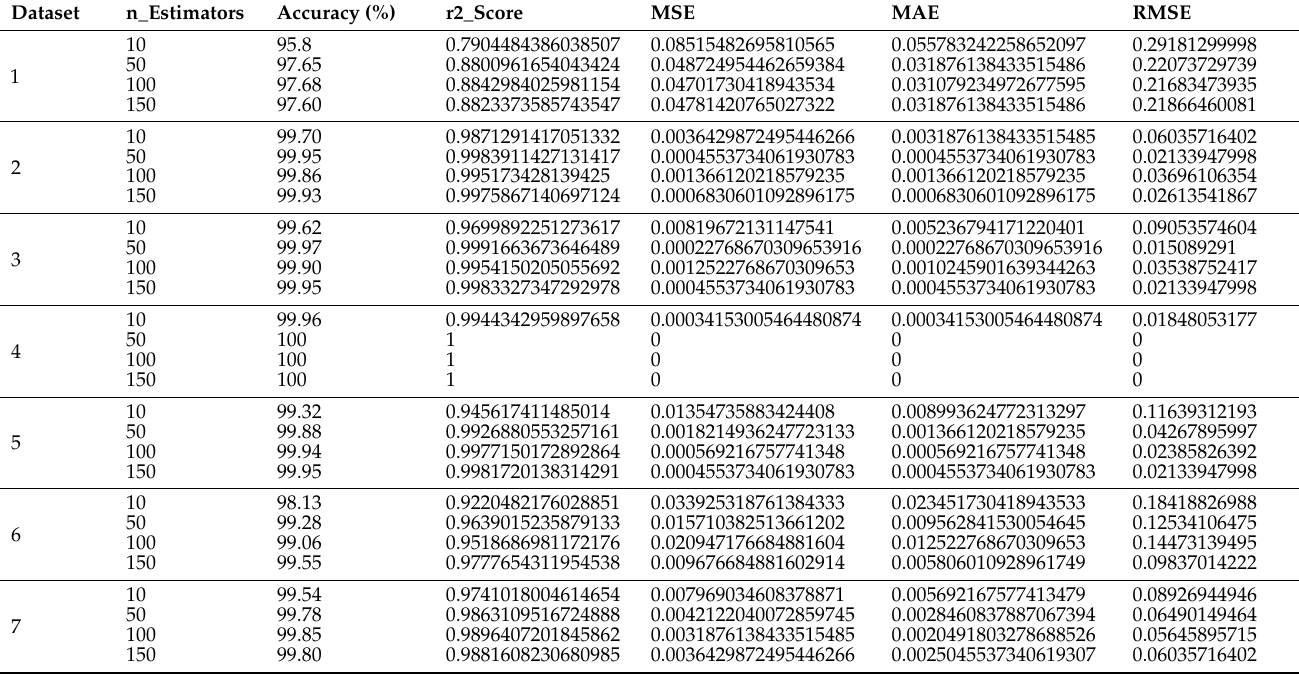
Table 5. Impact of n_estimators on the performance of the random forest with random_state = 0.